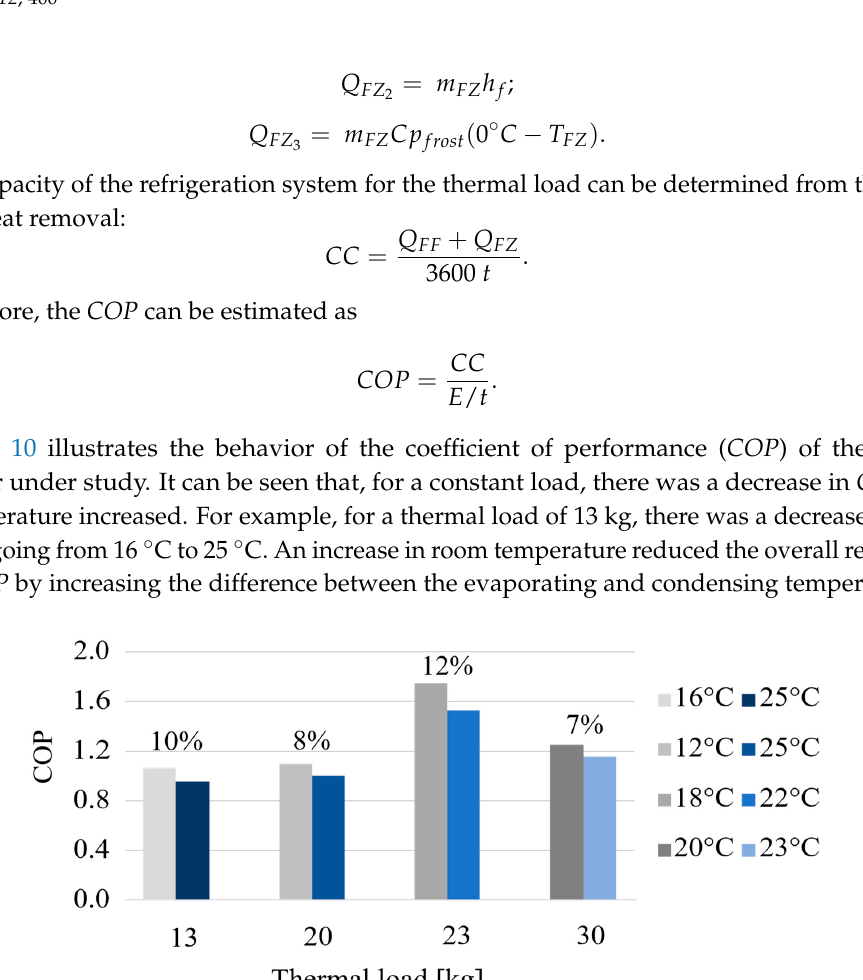
Table 4. Energy behavior for different thermal loads. 372